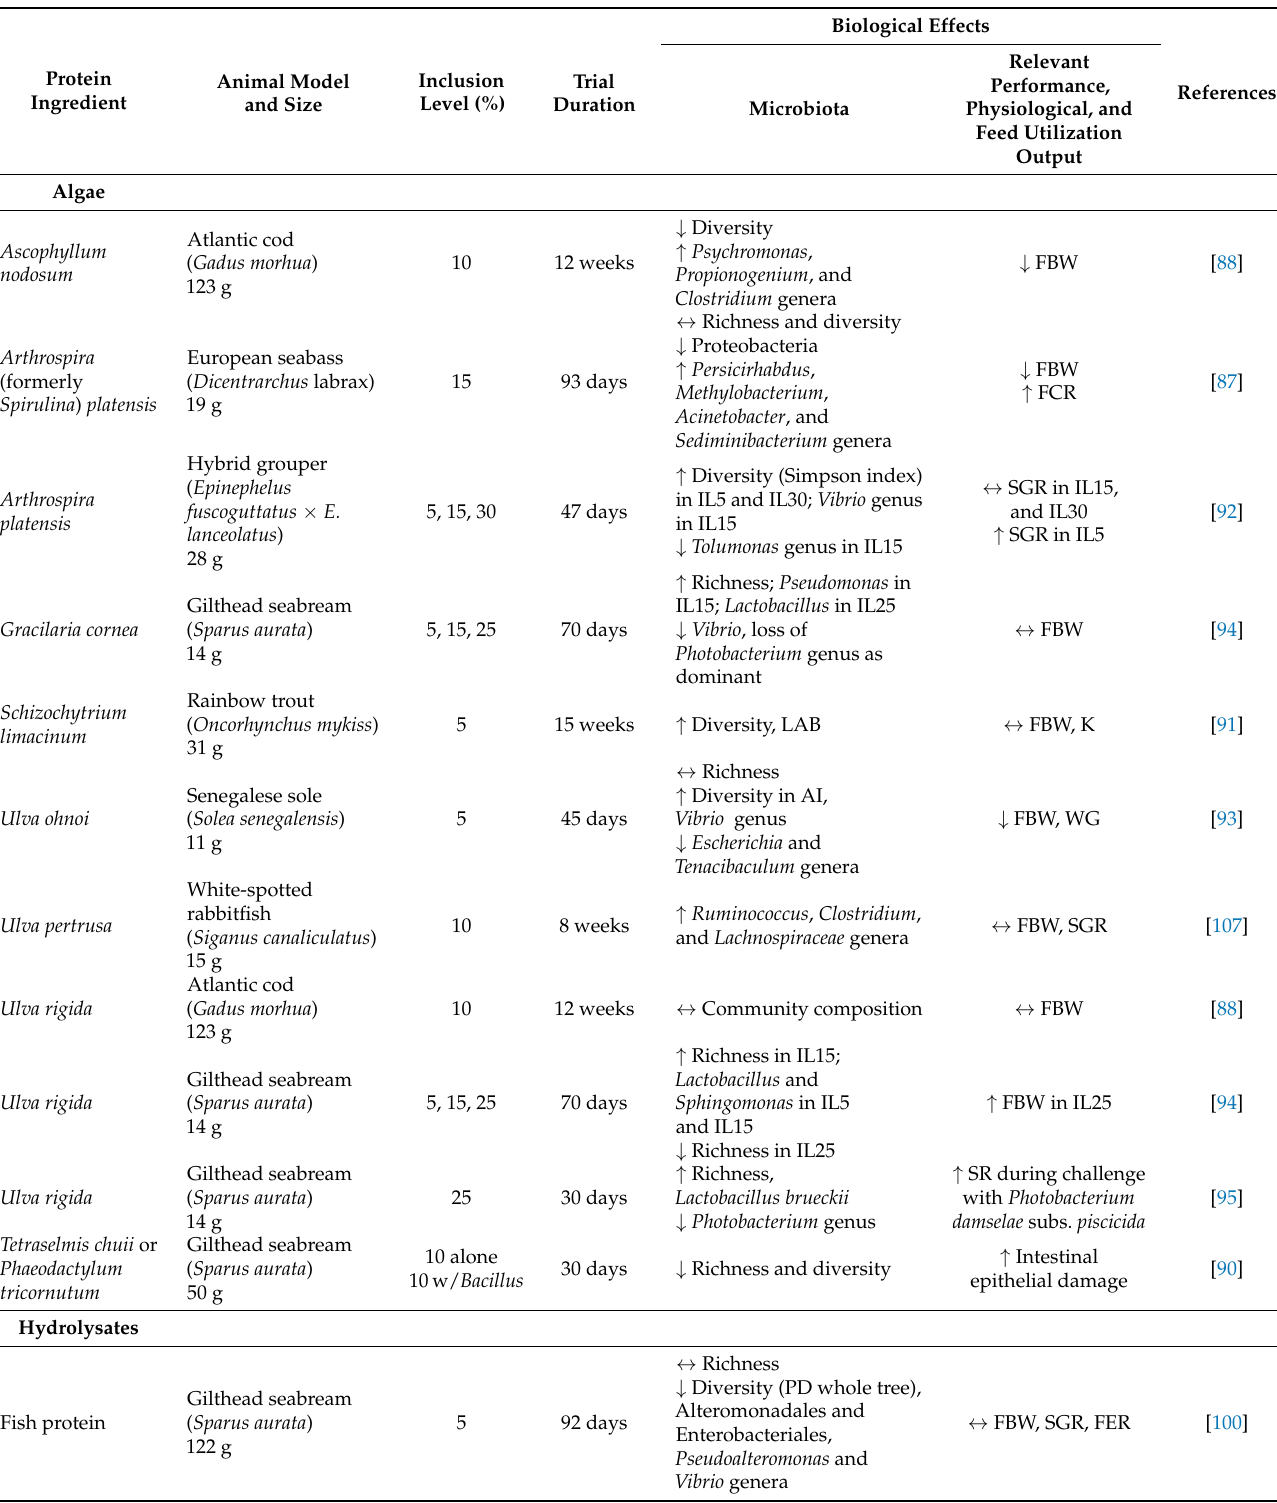
Table 1. Summary of alternative proteins (algae, hydrolysates, and yeast-based) and their impacts on fish intestinal microbiota